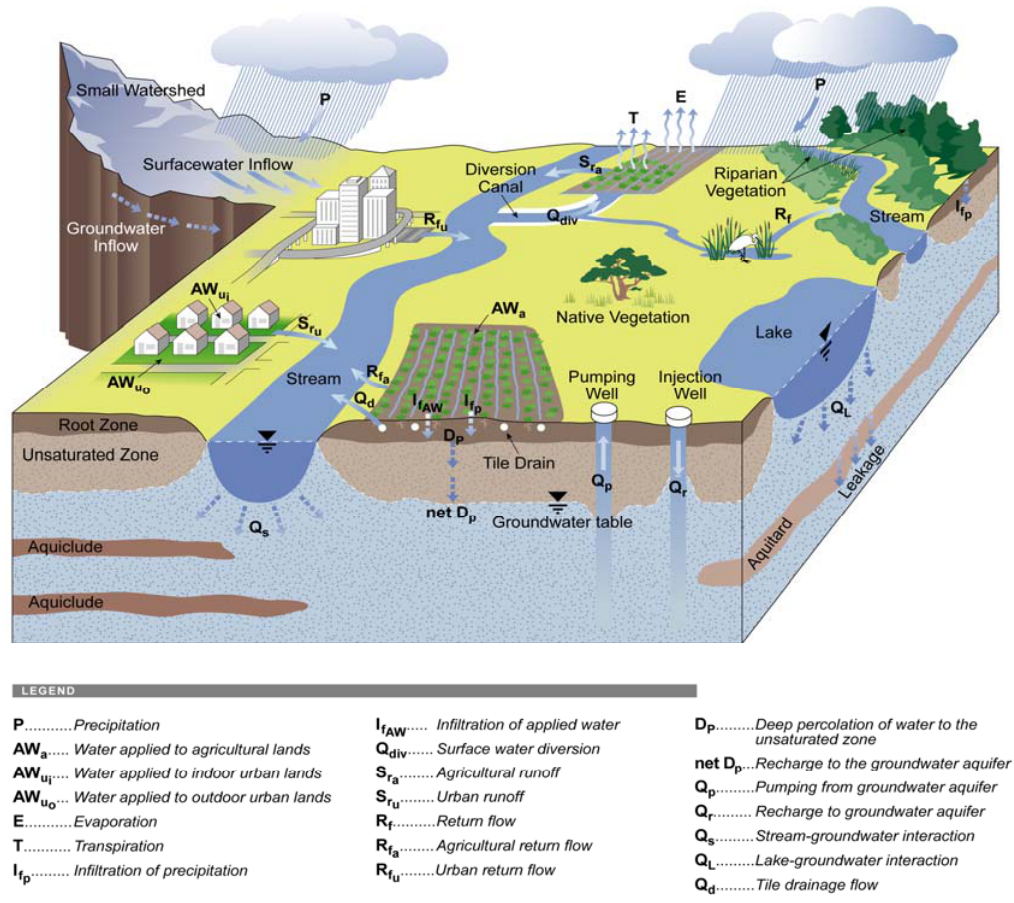
Figure 1. Hydrologic processes simulated by IWFM.